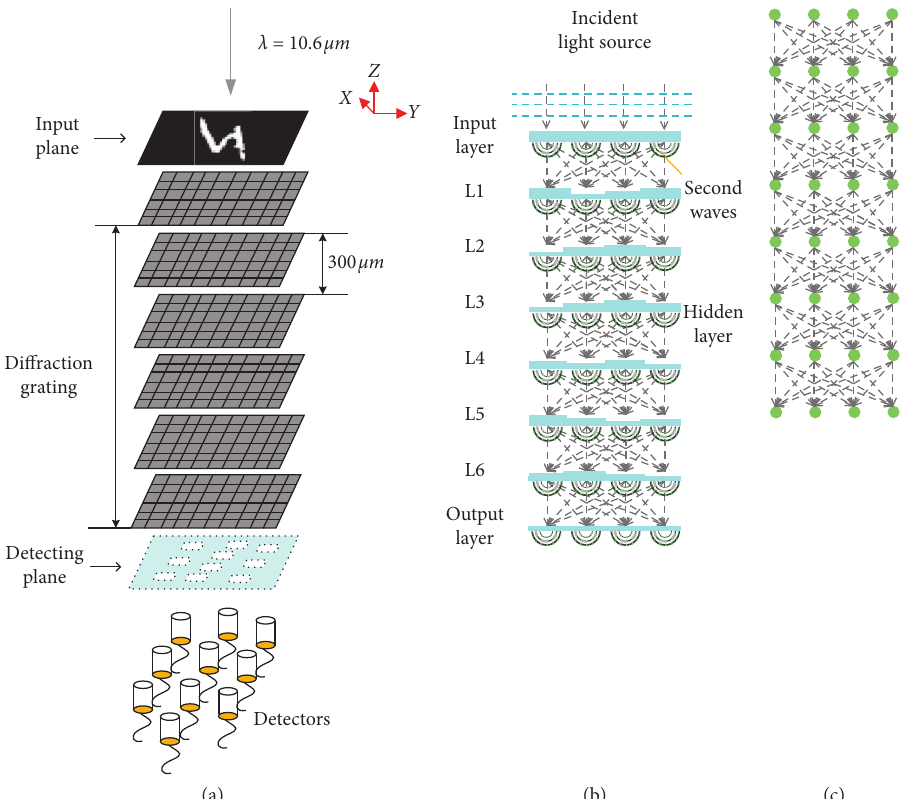
Figure 1: Schematic diagram of the N-D 2 NN structure. (a) System physical model. (b) Optical path model. (c) Neural network model.